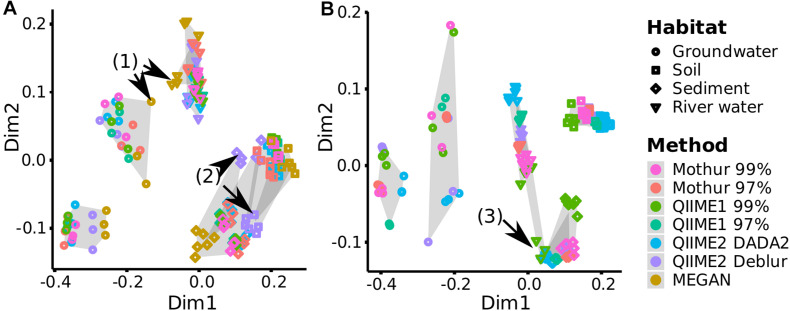
Comparison of beta-diversity plots for environmental samples. For each analysis pipeline, (A) Bray-Curtis dissimilarity (quantitative) or (B) Unweighted UniFrac distances (qualitative and phylogenetic) were subjected to NMDS (Non-metric Multidimensional Scaling) ordination and combined by Generalized Procrustes Analysis (NMDS stress values <0.06, Supplementary Table 7). Gray shading marks sampling sites, e.g., all three replicates analyzed by the different pipelines from one sampling site are connected by gray background. Black arrows highlight differences discussed in the text.